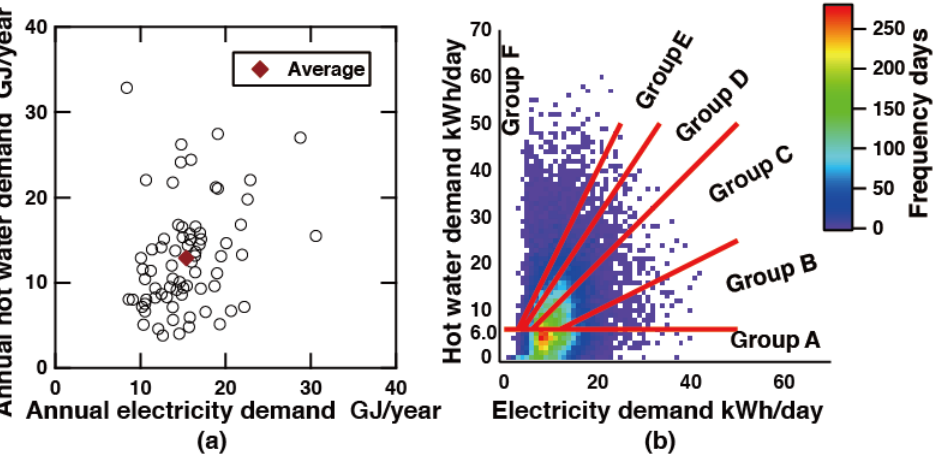
Figure 2. Measured demand. ( a ) annual; ( b )